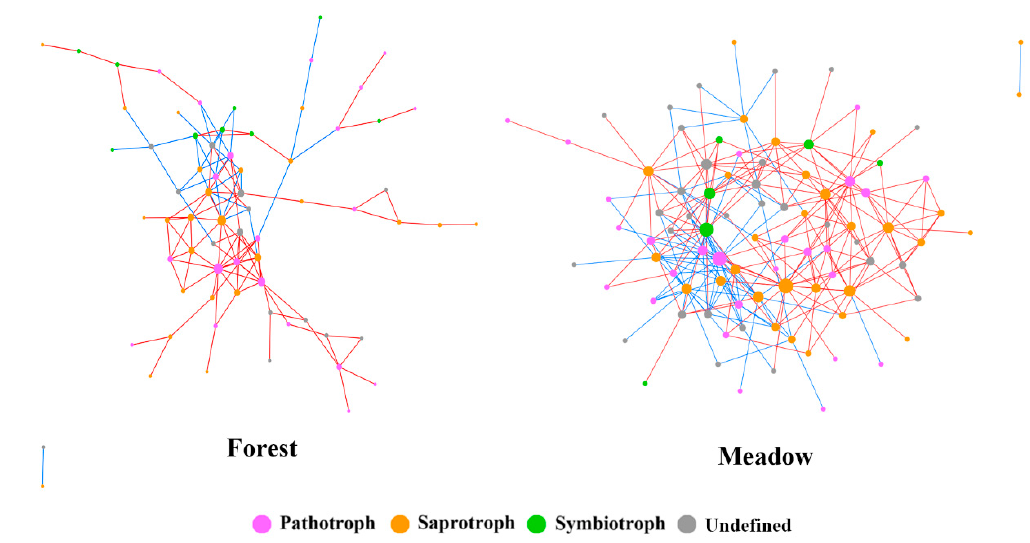
Figure 5. Ecological networks of soil fungal communities between forest (below the treeline) and meadow (above the treeline). The red line indicates a positive correlation, and the blue line indicates a negative correlation. The colours of the nodes represent different trophic modes. The size of each node is proportional to the connectivity.